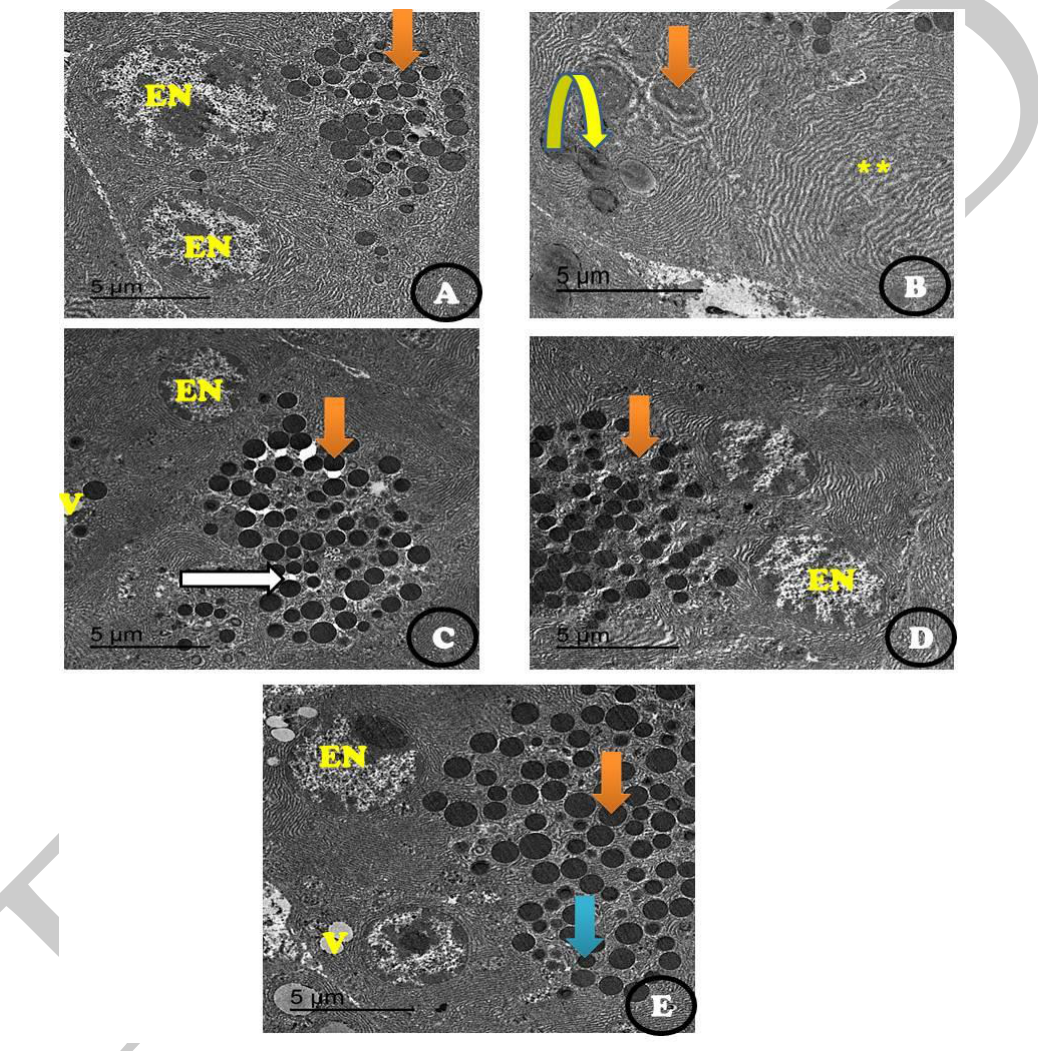
Figure 6. An electron micrograph of β -cells of the pancreatic tissues showing ( A ) the control group with normal β -cells (orange arrow) and many normal euchromatic rounded nuclei (EN), as well as normal-sized β -granules. ( B ) STZ treated group showing fibrotic pancreatic parenchyma (yellow star) with a reduced nucleus (orange arrow) with very few beta granules with the appearance of some empty granules (inverted yellow arrow). ( C ) STZ + stem cell group showing the restoration of almost all pancreatic parenchyma with the appearance of many moderate, dark, dense β -granules (orange arrow) and mild β -granular areas (white arrow) as well as a normal euchromatic nucleus (N) and some vacuoles (V). ( D ) STZ + vit. D group showing some restoration of pancreatic parenchyma with the appearance of many moderate- to small- sized β -granules (orange arrow) and a euchromatic nucleus (EN). ( E ) STZ + stem cell + vit. D group showing the restoration of almost all pancreatic parenchyma with many enlarged β -granules (orange arrow) and some moderately sized β granules ( blue arrow) as well as the appearance of some vacuoles (V) with an enlarged Bi-euchromatic nucleus (EN) (Scale bar = 5 µm).